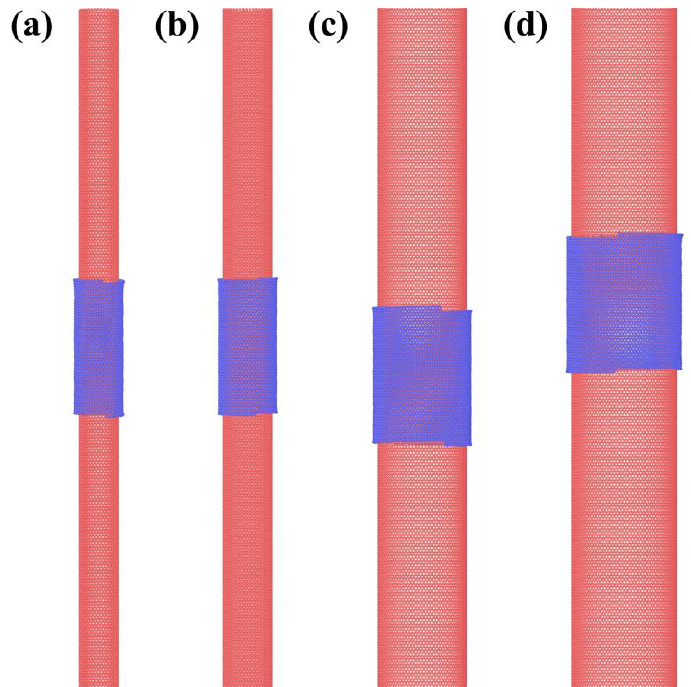
Figure 3. Self-assemble of GNR on the surface of zigzag SWCNTs. The chiral indexes of these SWCNTs from ( a – d ) are (36,0), (45,0), (82,0) and (98,0). The length of the GNRs are 10.99 nm, 13.21 nm, 10.99 nm and 22.31 nm, respectively. The obtained θ values are 1.1 ◦ for ( a , c ) and 0.93 ◦ for ( b , d ), both values correspond to superconducting magic angles.